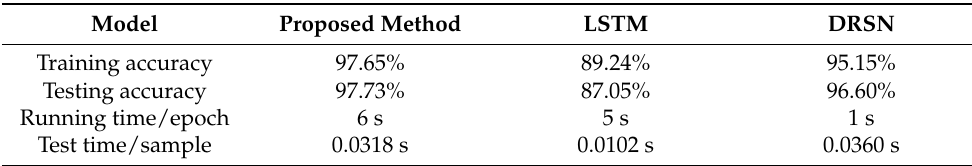
Table 7. Execution result of different models.